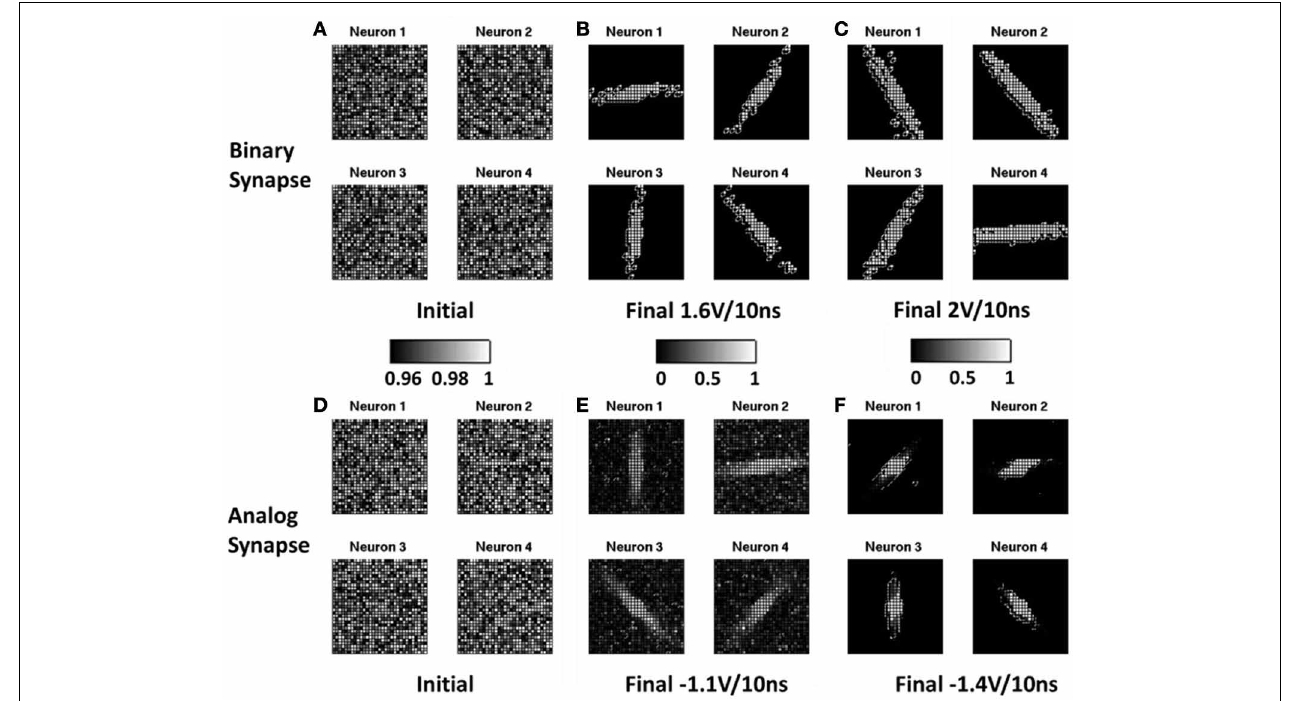
FIGURE 5 | Simulated normalized conductance map between the input layer neurons and the output layer neurons utilizing binary synapse with stochastic learning (A–C) and analog synapse with depression-only learning (D–F). The normalization is done with respect to a reference that is the highest conductance in the synapse array before the training. Initially, the resistances of all the oxide synaptic devices were randomized with a distribution centered at on-state for binary synapse (A)